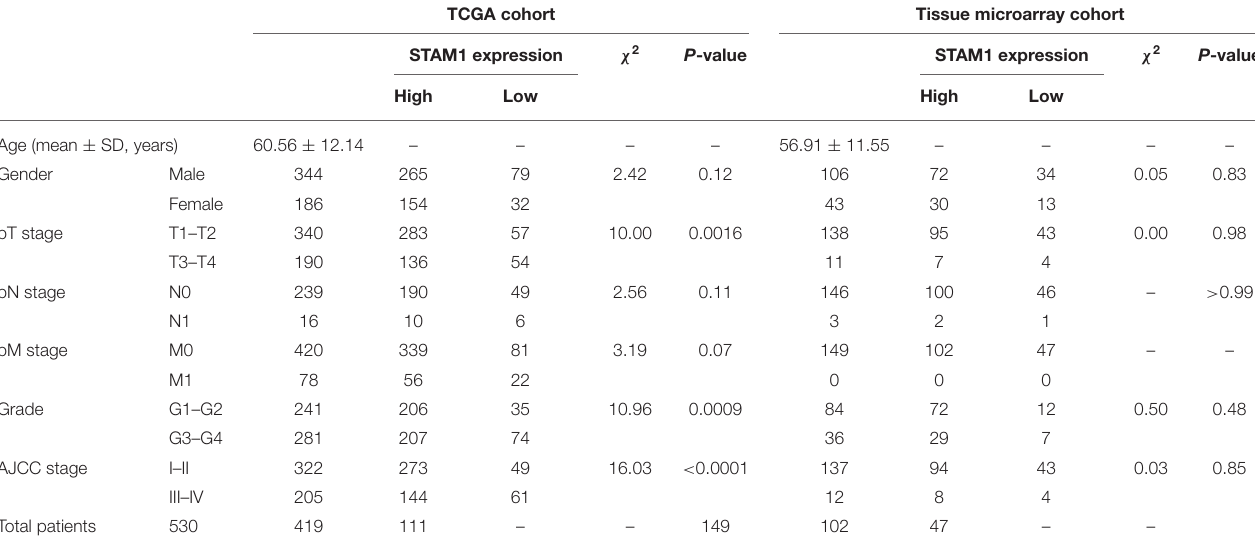
TABLE 1 | Characteristics of ccRCC patients from The Cancer Genome Atlas (TCGA) and tissue microarray cohorts.